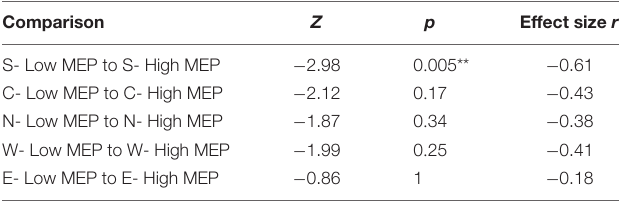
TABLE 4 | Two-tailed Wilcoxon signed rank tests between averaged N100 amplitudes in trials with high and low MEPs tested against each other within one stimulation